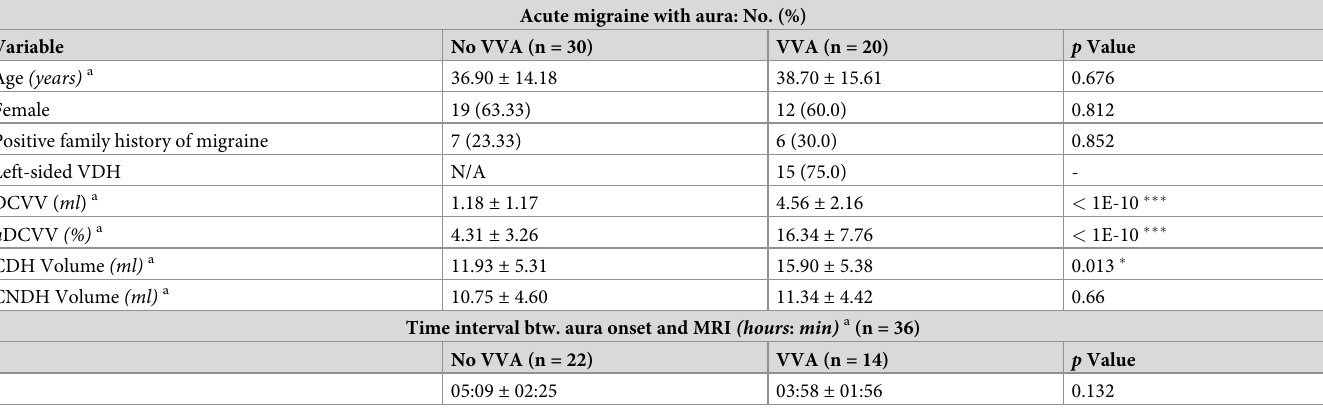
Table 1. Baseline characteristics of 50 patients with acute migraine with aura who received a 1.5T MRI. Acute migraine with aura: No.